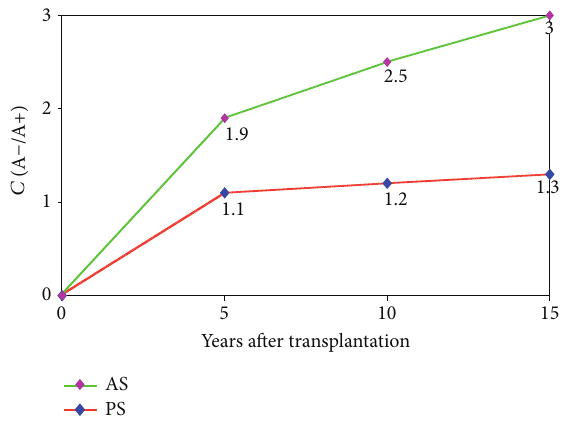
Figure 1: Correlation ( 𝐶 ) of long-term survivability of patients (PS) and allografts (AS) depending on absence or presence of anemia (A − /A+).